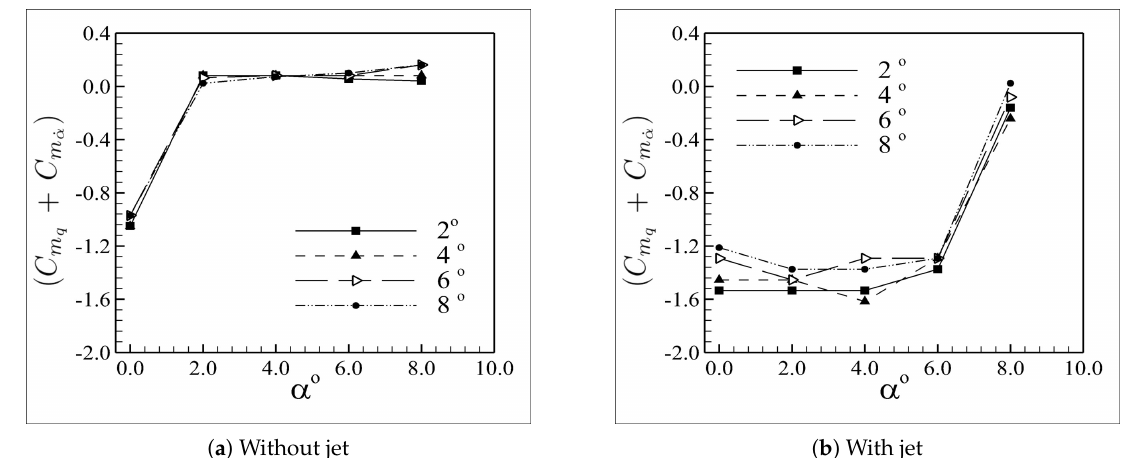
Figure 17. Effects of opposing jet on the dynamic pitching coefficient ( C m PR = 3, M j = 1 and M ∞ =